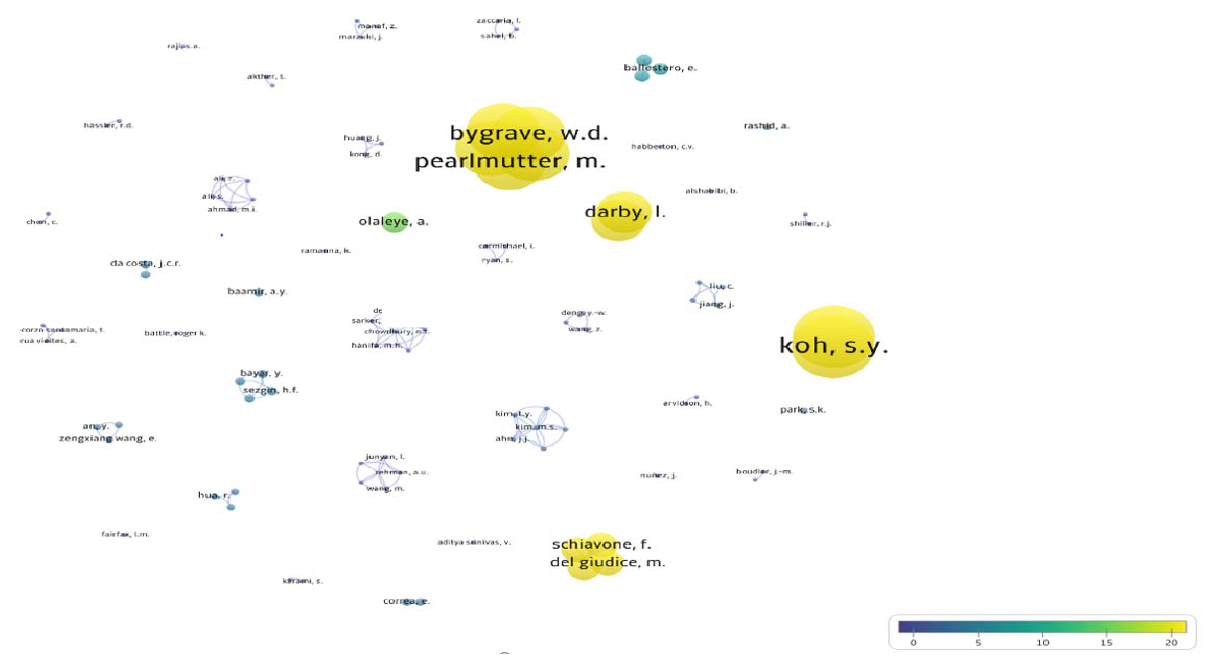
Figure 5. Visual representation of bibliographic coupling; Author.